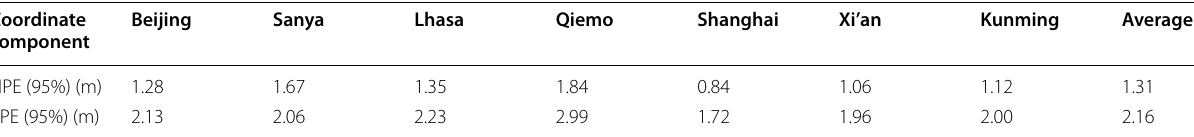
Table 2 Dual-frequency positioning accuracy of BDSBAS Coordinate